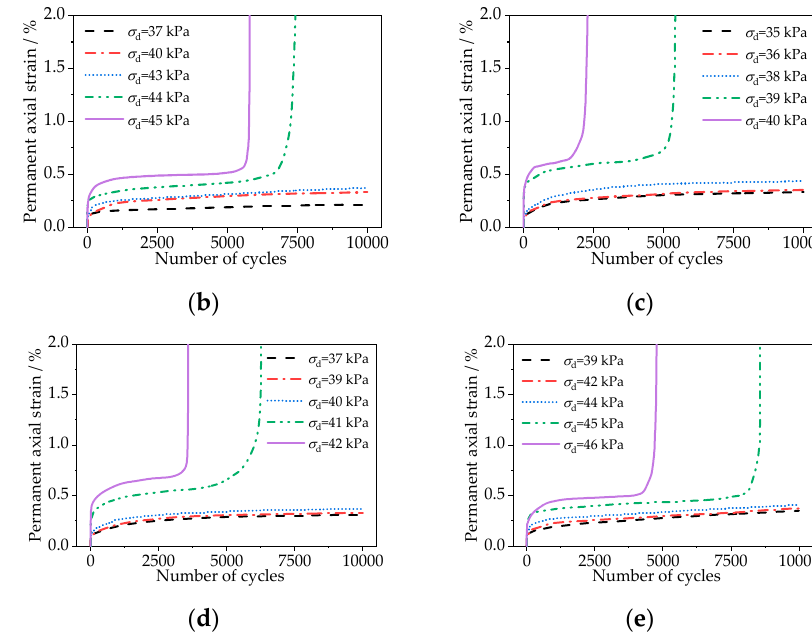
Figure 2. Permanent axial strain of the saturated silt with different fine particle contents under undrained conditions. ( a ) 7% fine particle content; ( b ) 8% fine particle content; ( c ) 10% fine particle content; ( d ) 12% fine particle content; ( e ) 14% fine particle content. Figure 3a,b are the stress paths at σ d = 40 kPa (stable mode) and σ d = 48 kPa (failure mode) with the fine particle content of 7%. With the increase in the number of cycles, p ’ and q remain almost unchanged when σ d = 40 kPa. When σ d = 48 kPa, p ’ continues to de ‐ crease and q remains stable at the initial stage. As the number of cycles approaches the critical value, the excess pore water pressure accumulates rapidly, and the sample has difficulty bearing the cyclic dynamic stress. The lower limit of q increases and the upper